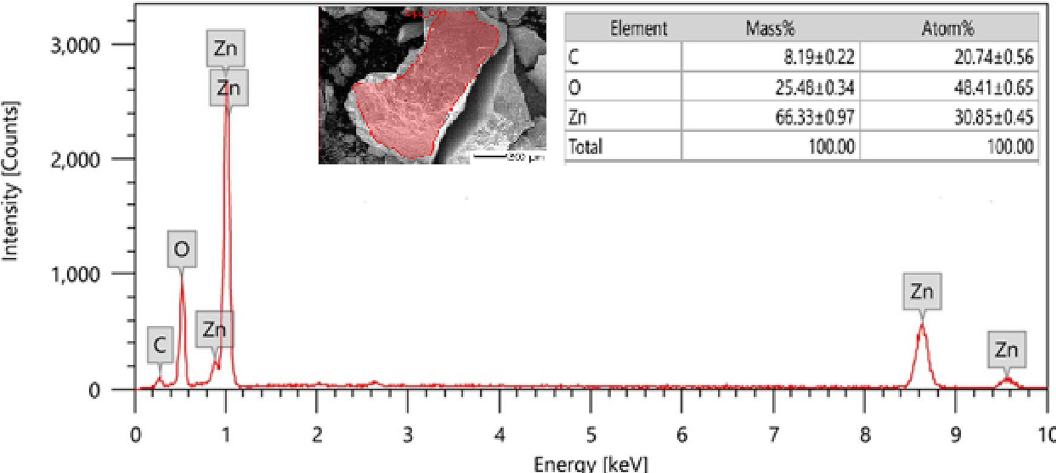
Figure 5. Energy dispersive x-ray spectroscopic analysis of Alk-ZnO NPs. Other elemental signal as carbon was also recorded possibly from enzymes or proteins present in the culture supernatant. Inset image of scanned area and elemental